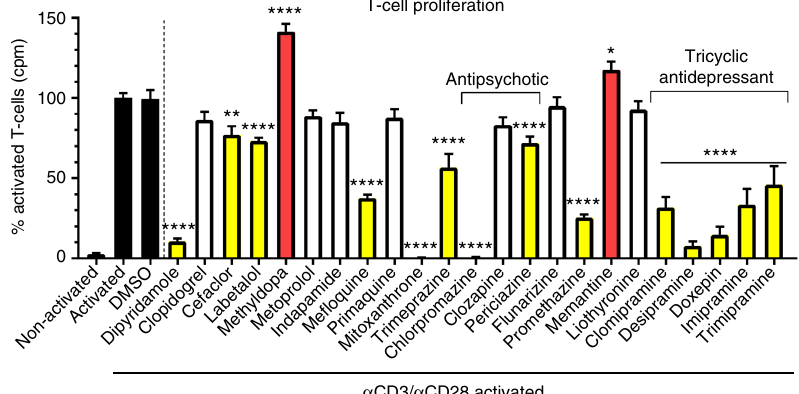
Fig. 5 Effects on proliferation of T-lymphocytes. The tricyclic antidepressants (clomipramine, desipramine, imipramine, trimipramine, and doxepin) reduced proliferation of T-cells markedly ( p < 0.0001). Data were normalized to counts per minute (cpm) of activated control T-cells. Shown are data pooled from two independent experiments each performed in quadruplicates. Data are depicted as mean ± SEM. One-way ANOVA with Dunnett's multiple comparisons test as post hoc analysis compared to activated splenocytes. * p < 0.05; ** p < 0.01; **** p < 0.0001